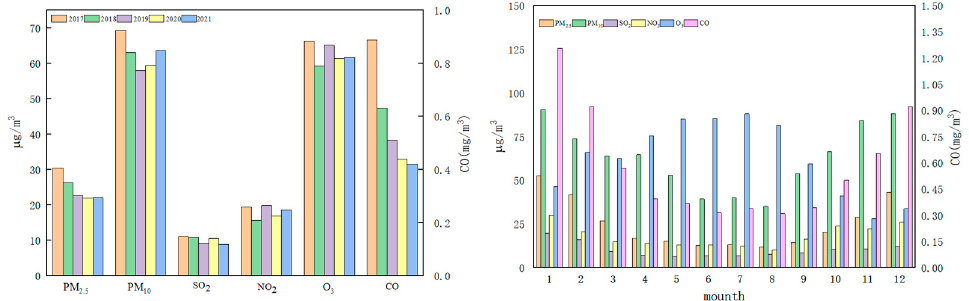
Figure 3. Variation chart of the concentrations of six pollutants, and average monthly concentrations of pollutants in Bozhou from 2017 to 2021.